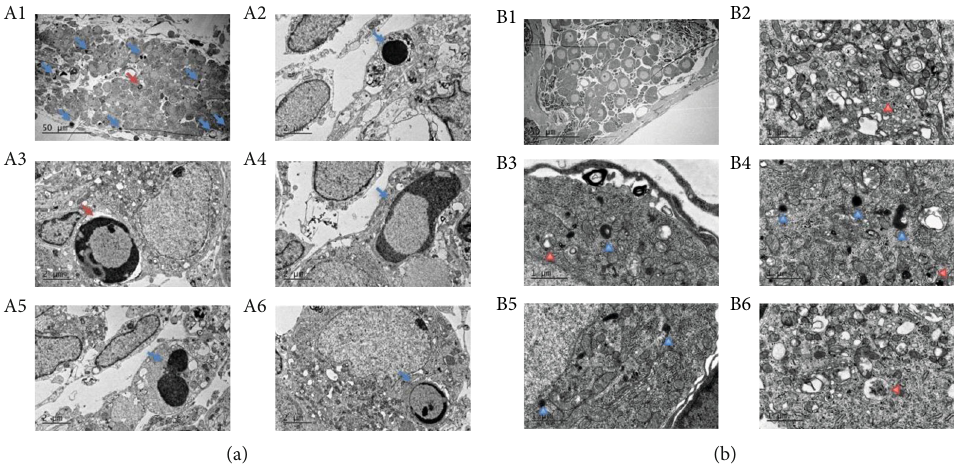
Figure 2: TEM observation of apoptosis and autophagy in SGNs during postnatal development. (A1) The overview of SGNs at P1 showing many apoptotic bodies (blue and red arrow). Scale bars = 50 μ m. The morphological di ff erences among various apoptotic cells and nuclear chromatin condensation: (A4) some condensed chromatin moves under the nuclear membrane or (A3) assumes a crescent shape; (A2) some condensed chromatin occupies the whole nuclear area. Scale bars = 2 μ m. (A5) The arrow indicates the cell body of secondary necrosis. Scale bars = 2 μ m. (B1) The overview of SGNs at P7, scale bars = 50 μ m. (B2, B3, B4, and B6) Red arrows indicate autophagosomes, which are presented as double membrane structures and contain a cytoplasm or organelles. (B3 – B5) Blue arrows represent autolysosomes. Scale bars = 1 μ m.